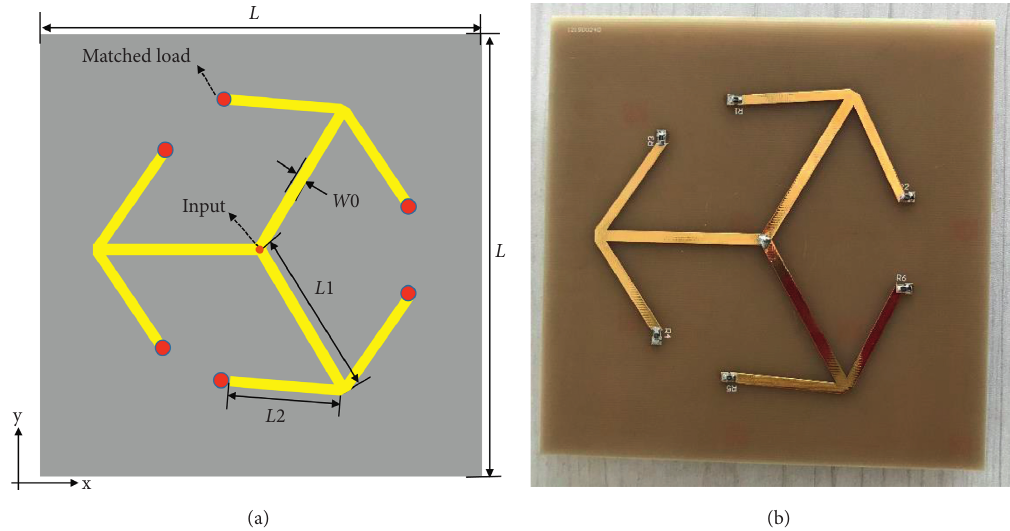
Figure 1: Configuration of the three-branch antenna. (a) Schematic diagram of structure. (b) Physical processing diagram.